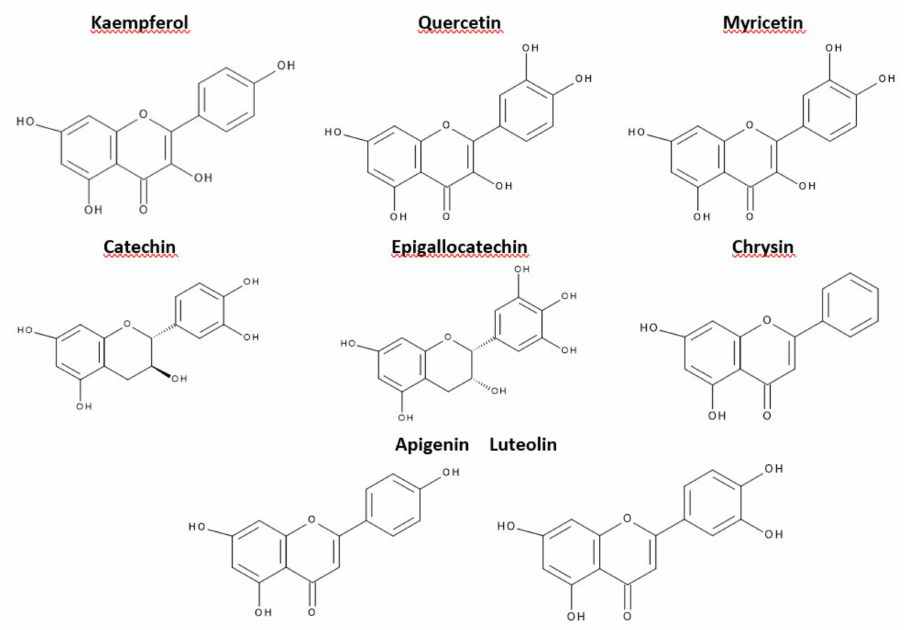
Figure 3. Structures of selected